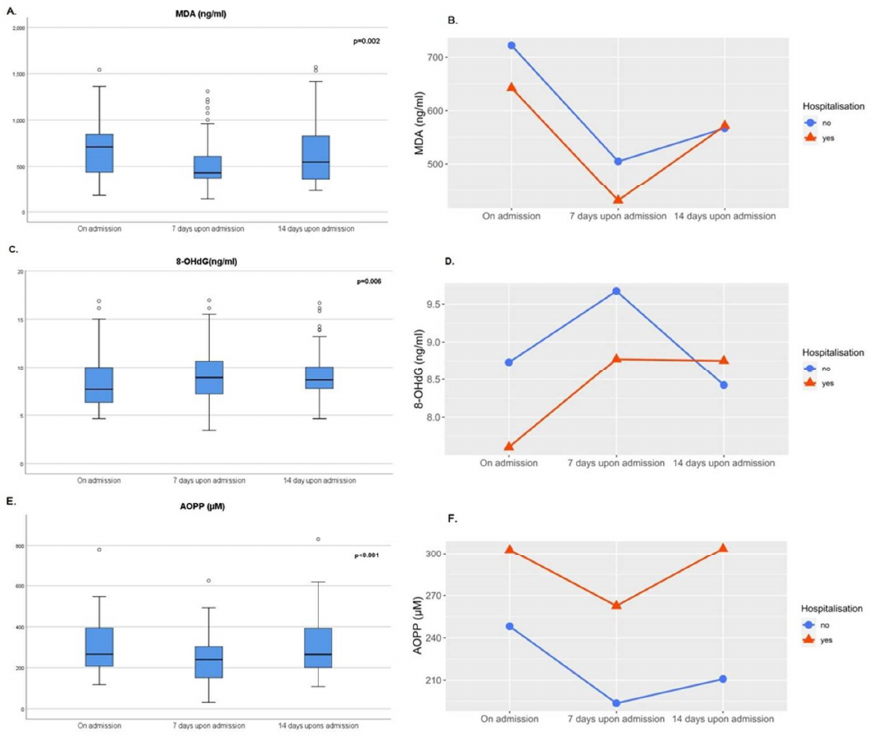
Figure 1. The time course of total ( A , C , E ) and individual redox biomarkers (MDA, 8-OHdG, AOPP) in hospitalized and non-hospitalized patients with COVID-19 pneumonia ( B , D , F ); MDA—malondialdehyde; 8-OHdG—8-hydroxy-2’- deoxyguanosine; AOPP—advanced oxidation protein products; p